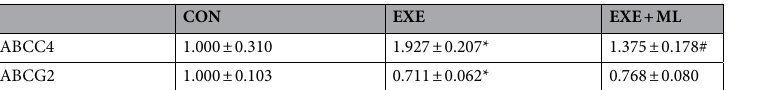
Table 8. ABCC4 and ABCG2 protein expression of NRK-52E cell. *Significantly different from CON ( p < 0.05), #Significantly different from EXE ( p < 0.05).